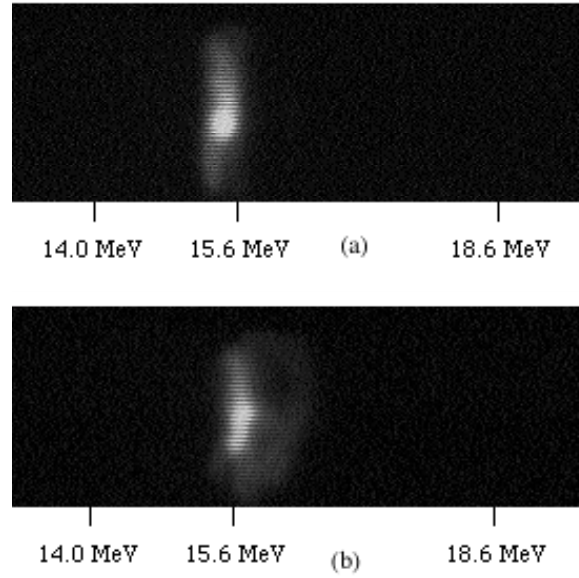
FIG. 9. Video image made by beam, with plasma present, in momentum analyzing spectrometer, for (a) a good acceleration case (cid:3) Q (cid:1) 19 nC (cid:4) and (b) a case where the tail is deflected, and less acceleration is observed. Note hot spots centered at distinct